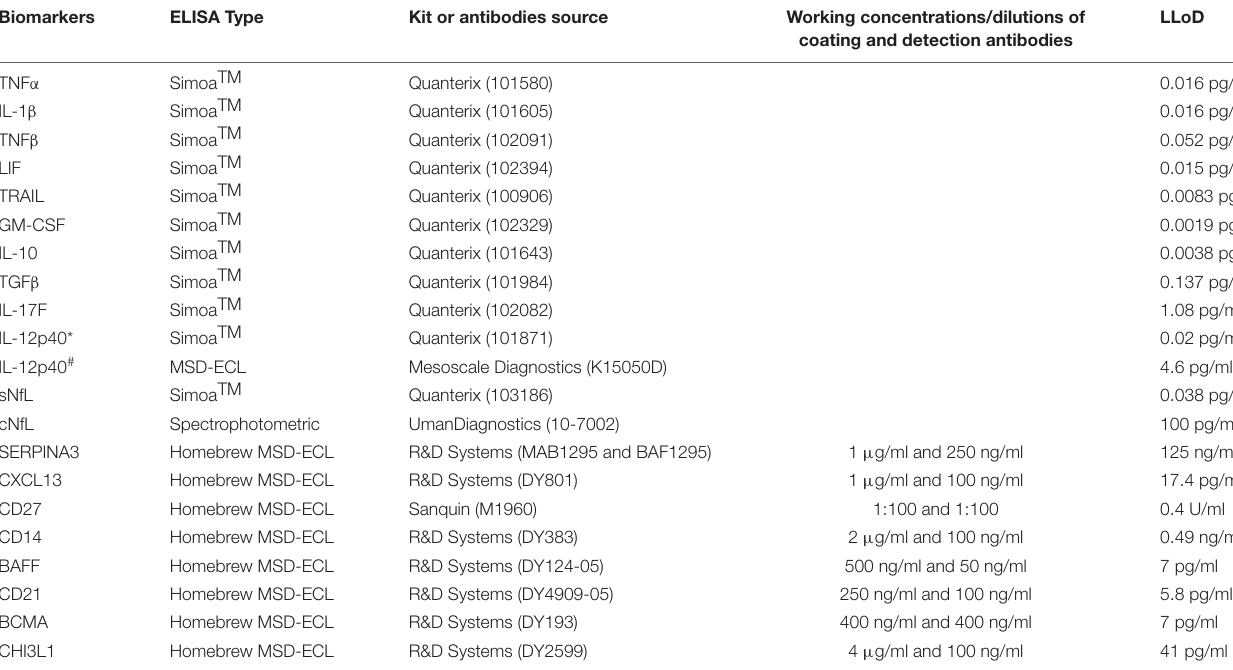
TABLE 2 | List of kits and antibodies used for biomarker analyses using either Simoa (Quanterix) or spectrophotometric or homebrew MSD-ECL ELISAs; working concentrations or dilutions of coating and detection antibodies for homebrew assays and lower limit of detection (LLoD) of all assays is provided here. IL-12p40 in training ( ∗ ) and validation ( # ) cohort was analyzed using Simoa and MSD-ECL ELISA, respectively.